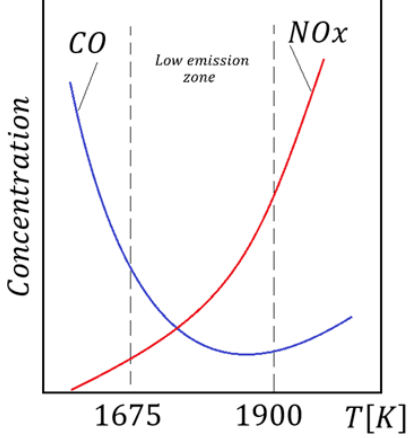
Fig. 2. Effect of combustion temperature on nitrogen oxide formation (basing on